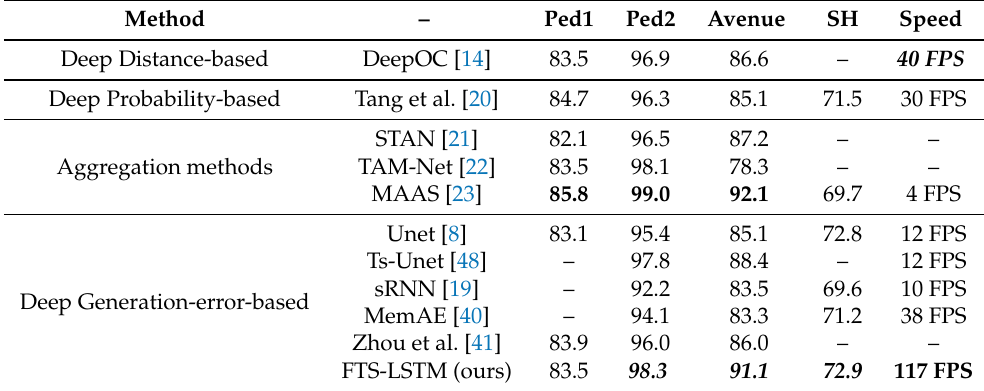
Table 1. Frame-level ROC/AUCs of different methods. The bold font represent the optimal perfor- mance, and the bold italic font represent the suboptimal